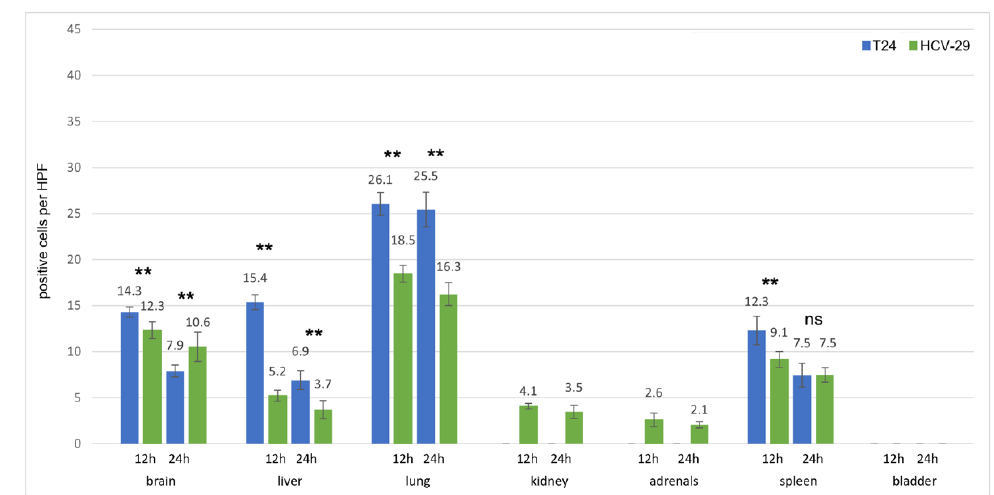
Figure 8. Uptake of fluorescence labeled T24 and HCV-29 EVs after intravenous injection. The number of EV-positive cells per high power field (HPF) is given for each organ and each time point. Columns for T24 EVs are depicted in blue, those for HCV-29 EVs in green. Medians +/− standard deviations are given. For each column, ten randomly chosen HPFs from two mice (5 per mouse) were analyzed. Significances were calculated using a 2way ANOVA test with Bonferroni correction. ** p < 0.01, ns = not significant.